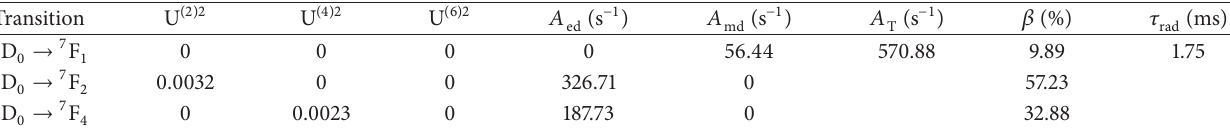
Table 2: Predicted spontaneous transition probabilities, branching ratios, and radiative lifetime of EBA incorporated PMMA.